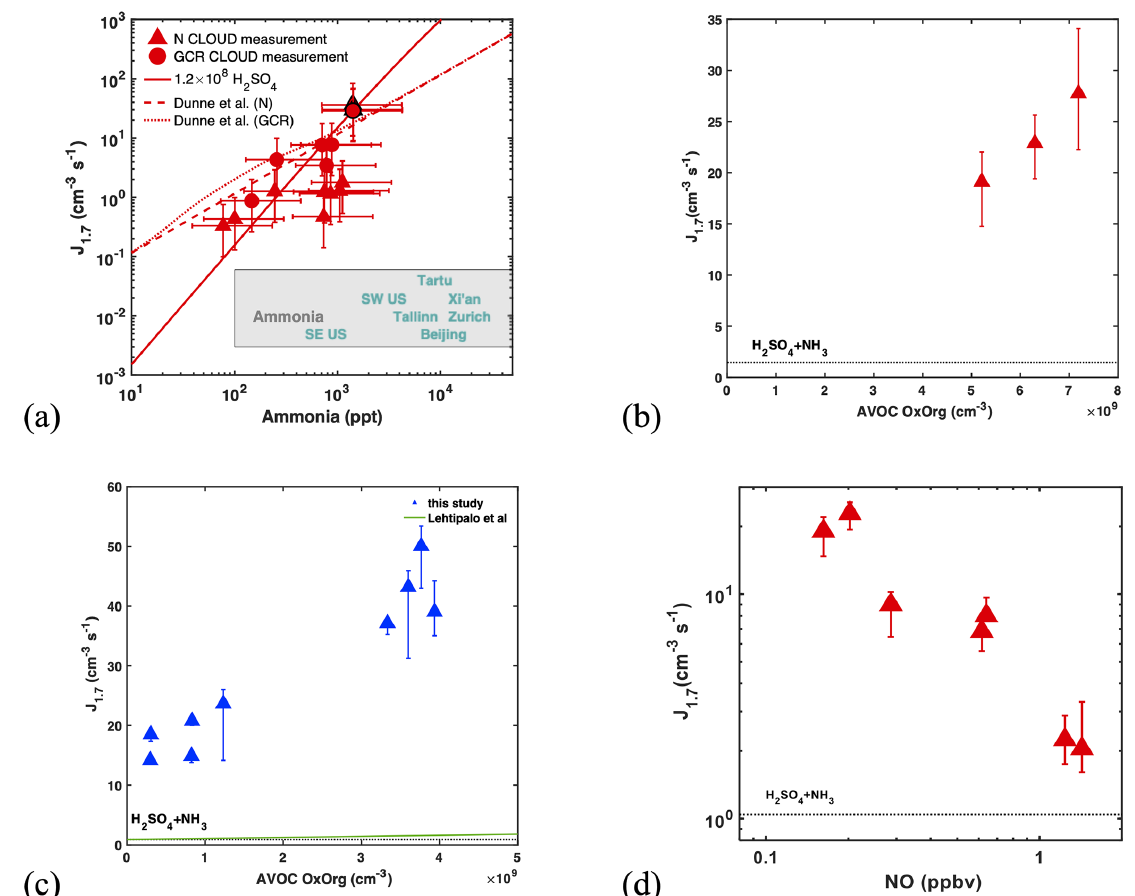
Figure 2. Dependencies of atmospheric particle formation rates ( J 1 . 7 ) on ammonia, organics and NO. (a) J 1 . 7 versus NH 3 at fixed H 2 SO 4 ((1.1–1.6) × 10 8 cm − 3 ) and temperature (292–295K). Red triangles are previous CLOUD measurements (Dunne et al., 2016) under neutral (triangle) or GCR (circle) conditions while the symbols with black outlines are new from this study. Error bars describe run-to-run repeata- bility of J in CLOUD, which is ca. 30%. The solid red line presents J 1 . 7 for 1 . 2 × 10 8 cm − 3 H 2 SO 4 at 293K from our kinetic model simulation and fits well to the additional data at the high NH 3 mixing ratio. The dashed (N, neutral) or dotted (GCR) red line shows the parameterization used by Dunne et al. (2016). Also shown are the mean concentrations of ammonia at various locations (Elser et al., 2018; Guo et al., 2017) as text of locations. (b) Experiments with (2.8 ± 0.3) × 10 7 cm − 3 H 2 SO 4 , 849 ± 20pptv NH 3 and 0.19 ± 0.03ppbv NO at 293K with NAPH:TMB:TOL of 1 : 2 : 10. Black dotted line in the plot displays J 1 . 7 for 1.9 × 10 7 cm − 3 H 2 SO 4 nucleating with 1000pptv of 1 : 5 : 30. Black dotted line in the plot displays J 1 . 7 for 8 × 10 6 cm − 3 H 2 SO 4 nucleating with 1600pptv NH 3 . Green solid line shows J 1 . 7 of 8 × 10 6 cm − 3 H 2 SO 4 nucleating with 1600pptv NH 3 , with BVOC OxOrg and with 0.2ppbv NO based on parameterizations in Lehtipalo et al. (2018). Oxidation of aromatic compounds by OH forms highly oxygenated molecules (HOMs) (Molteni et al., 2018; Wang et al., 2017) through autoxidation, leading to significant NPF, at rates even higher than observed for monoterpene oxidation. This is consistent with the finding that HOMs from aromatic compounds are less volatile than HOMs from monoterpene precursors at the same number of carbon atoms in the backbone (Wang et al., 2020). (d) J 1 . 7 versus NO at 293K, with fixed conditions for other vapours, i.e. (2.3 ± 0.4) × 10 7 cm − 3 H 2 SO 4 , 800 to 1000pptv ammonia, and an AVOC mixture yielding an OxOrg concentration of (5.2 ± 0.7) × 10 9 cm − 3 (among which is (0.9 ± 0.2) × 10 9 cm − 3 produced by NAPH oxidation, (2.1 ± 0.3) × 10 9 cm − 3 by TMB oxidation and (2.2 ± 0.3) × 10 9 cm − 3 by TOL oxi- dation). The error bars describe the variation of the measurements only and do not include a 30% run-to-run variability. The horizontal dotted line indicates J 1 . 7 for 2.3 × 10 7 cm − 3 H 2 SO 4 with 1000pptv NH 3 at 293K under GCR conditions. J 1 . 7 decreases with increasing NO since NO suppresses both autoxidation and the formation of low-volatility dimers. This efficient suppression of aromatic RO 2 isomerization to form autoxidation HOM products is in contrast to aromatic RO 2 isomerization rates to form bicycloalkyl radicals, which dominate the early stage of aromatic oxidation and outcompete NO reactions even at much higher NO concentrations (10 to 100s of ppbv) (Volkamer et al.,